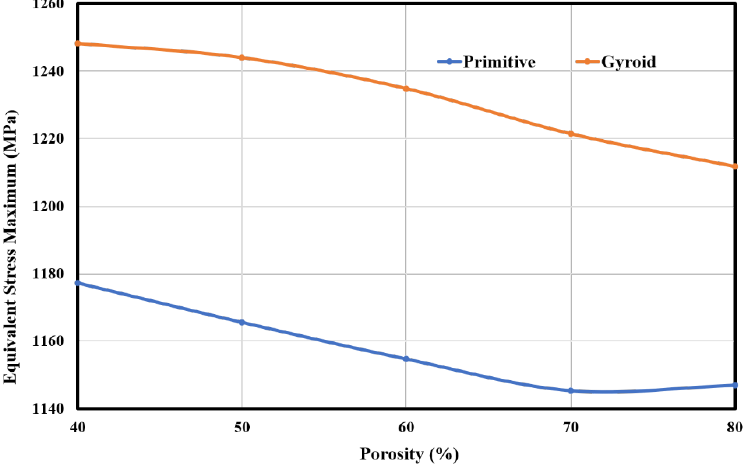
Figure 9. Maximum Von Mises stress at 5% strain rate for P and G with the porosities ranging from 40% to 80%. Table 1. Effective Young’s modulus and compressive strength obtained from the compressive loading on P and G lattice structures with varying